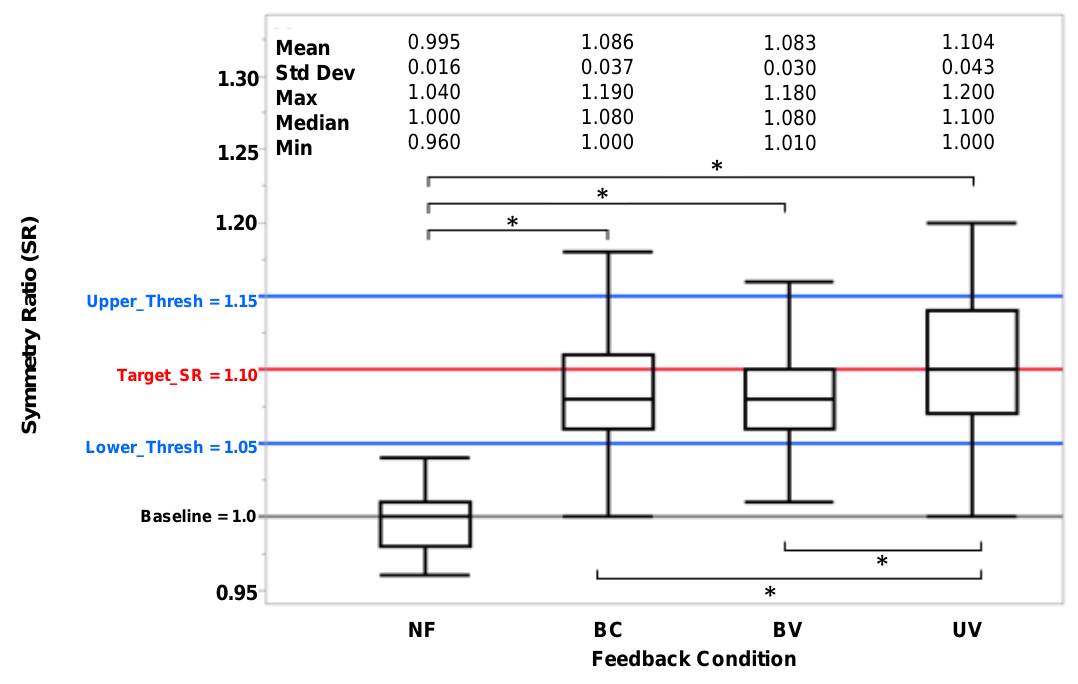
N F BCB V U V F ee db ack C ond i t i Figure 5: SR vs FB. Box plot of SR values for all feedback (BC, BV, and UV) and no feedback (NF) conditions. BC: Bidirectional control – constant vibration; BV: Bidirectional control – variable vibration; UV: Unidirectional control – variable vibration. Statistically significant differences between conditions are denoted with an ‘*’. Mean, standard deviations (Std Dev), maximum, median, and minimum values of SR are presented. Upper and Lower Thresholds labeled as Upper_Thresh and Lower_Thresh, respectively.